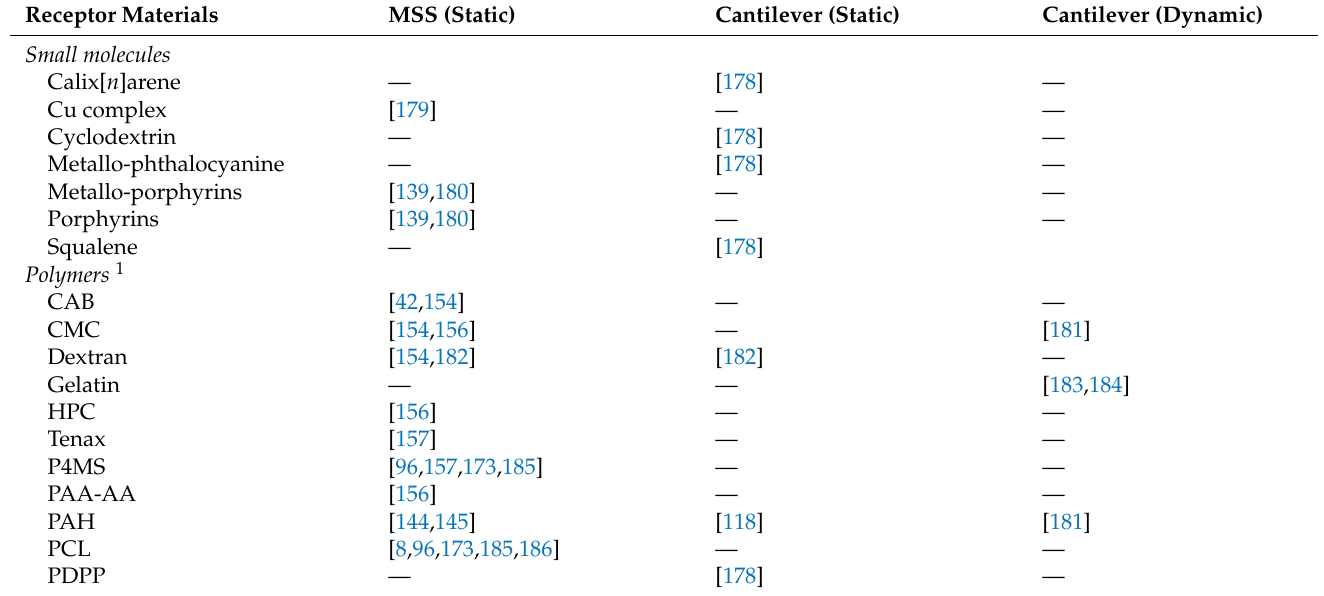
Table 1. List of receptor materials used for nanomechanical sensors including cantilever-type sensors and MSS in both static and dynamic mode